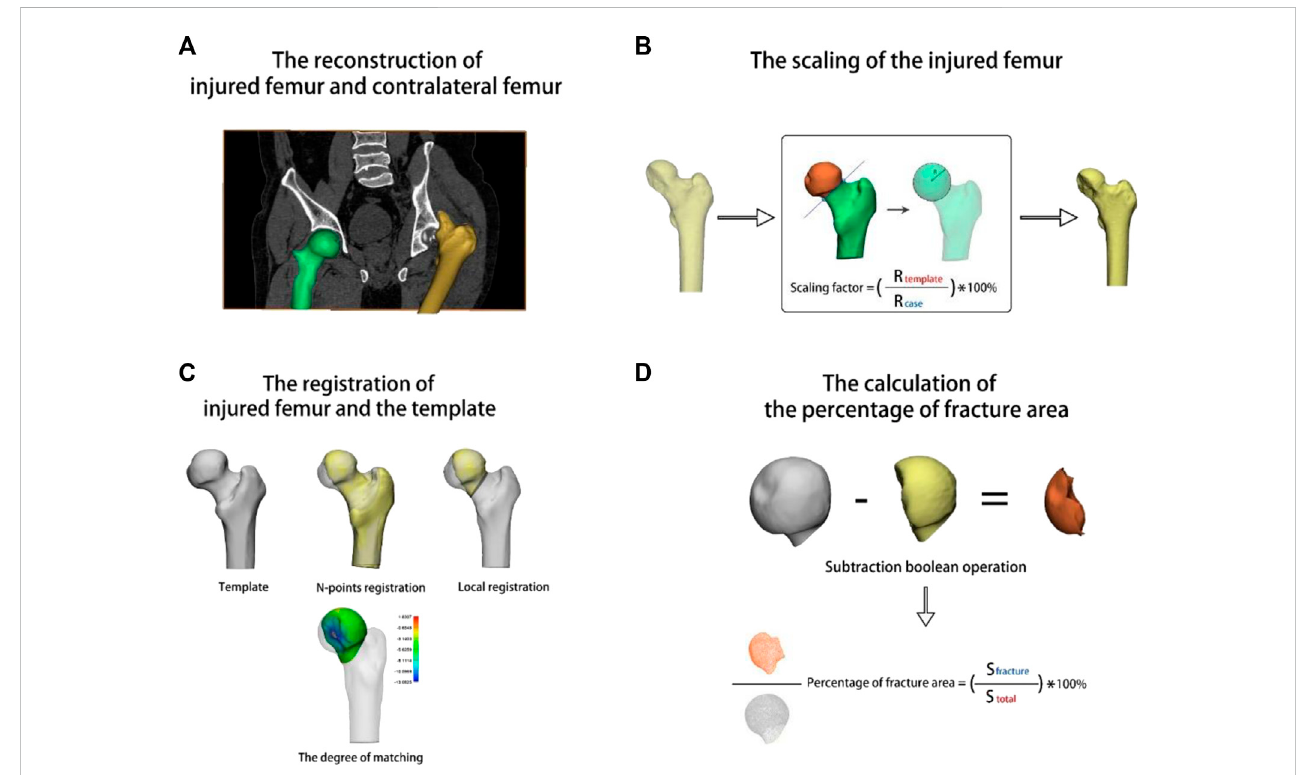
FIGURE A1 Flowchart of the 3D parameter